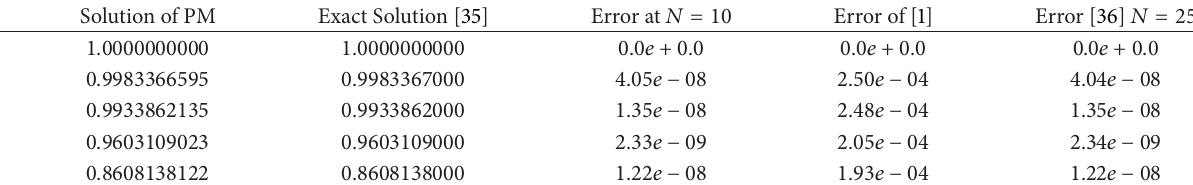
Table 4: The exact and approximated solution of Example 6 together with the error